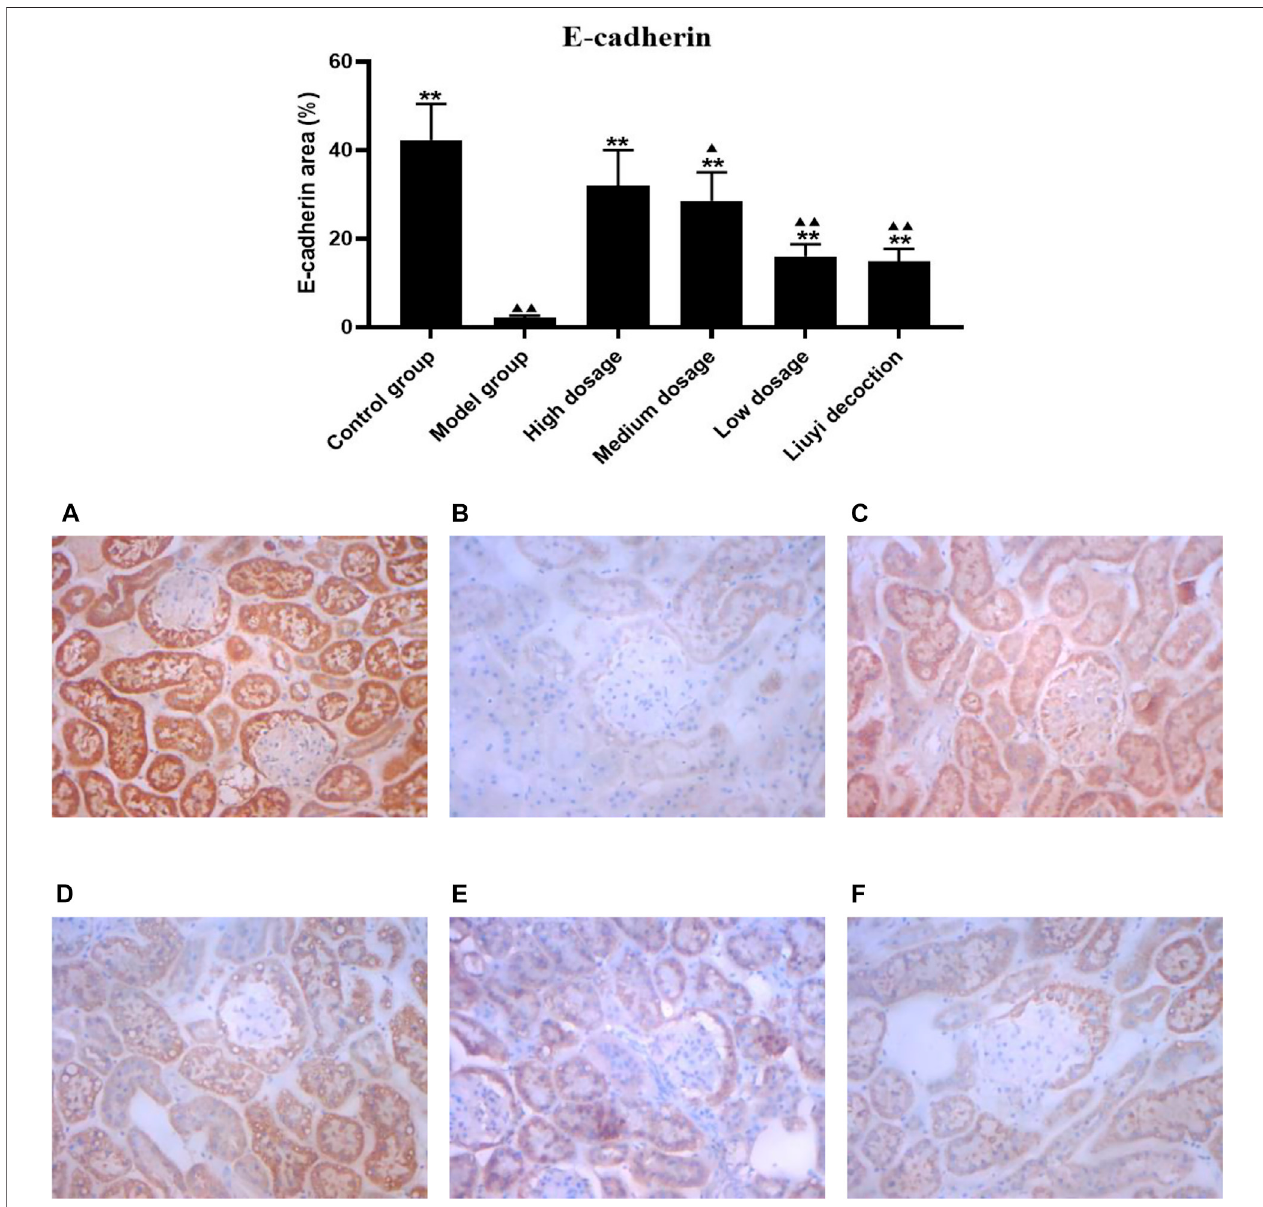
FIGURE 6 | Effect of HQD on the expressions of E-cadherin in kidney (×400). Control group (A) ; model group (B) ; high dosage (C) ; medium dosage (D) ; low dosage (E) ; Huangqi Liuyi decoction (F) . ps: vs. Model group, * P < 0.05, ** P < 0.01; vs. control group, ▲ P < 0.05, ▲▲ P < 0.01 (x±SD, n =6).